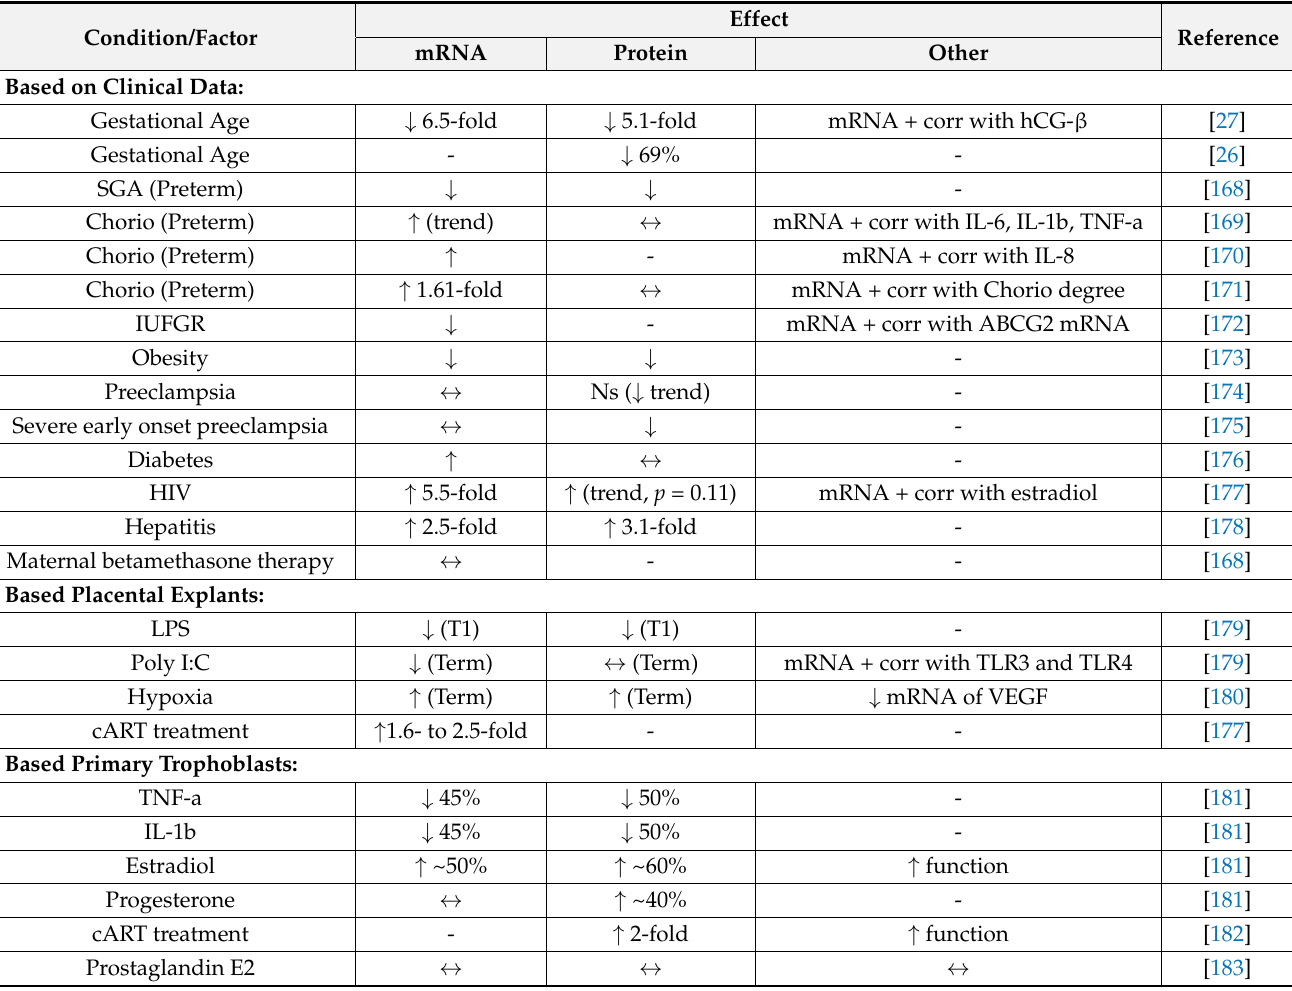
Table 1. Summary of ABCB1/P-gp alterations in the placenta in different physiological/ pathological